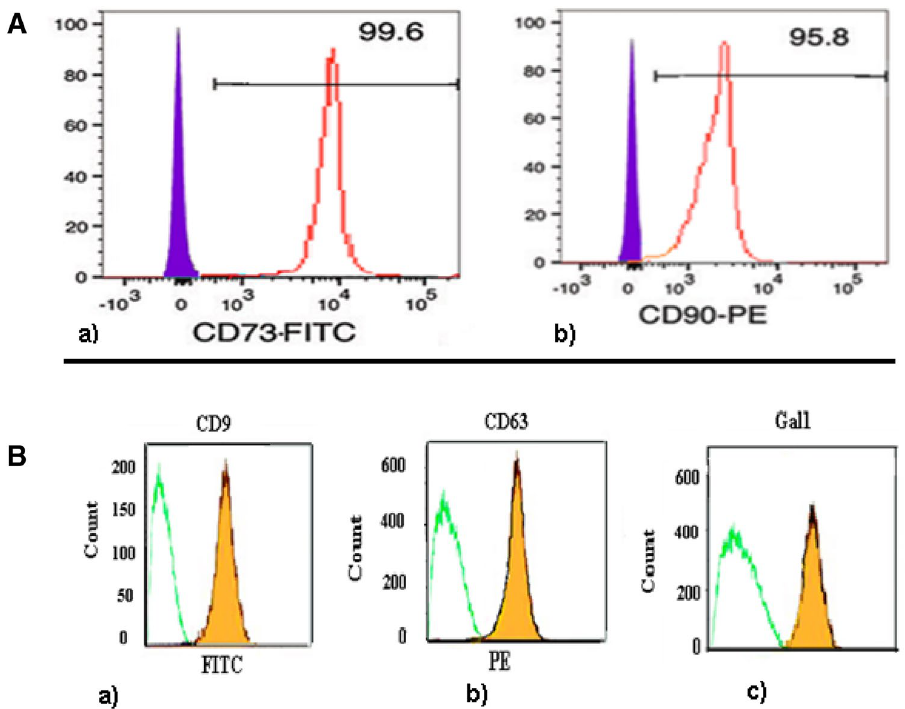
Figure 1. ( A ) Characterization of mouse bone marrow-derived mesenchymal stem cells. Flow cytometry analyses of cell surface markers showed that cultured cells were positive for mesenchymal stem cell markers of CD90 (99.6%) (a), CD73 (95.8%) (b). ( B ) Flow cytometry analyses of MVs surface markers. MVs coated on sulfate/aldehyde latex beads were positive for the surface expression of CD9 (95.6%) (a), CD81 (94.8%) (b), Gal-1 (84.8%)